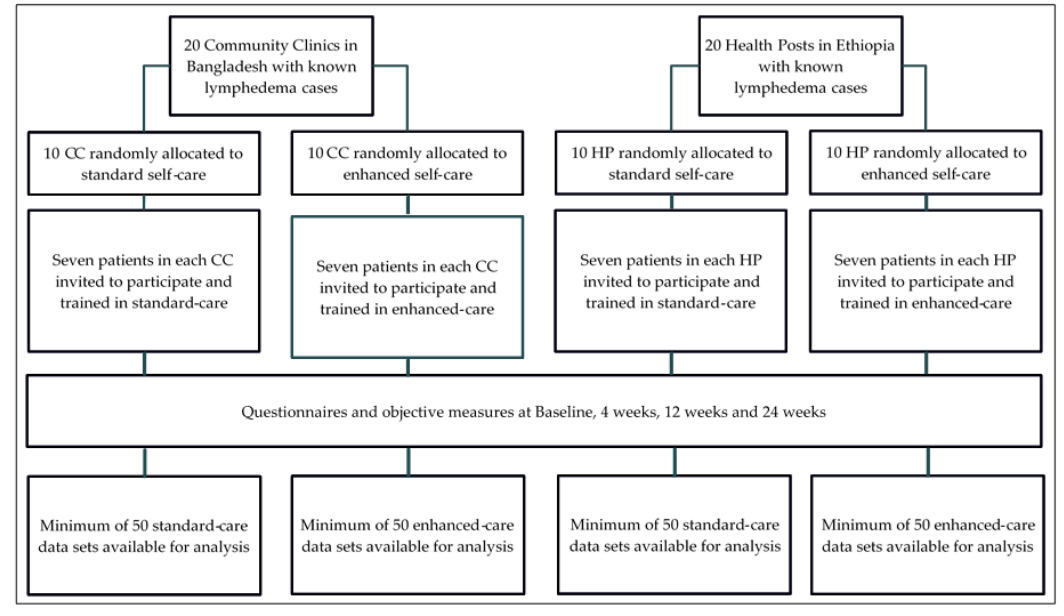
Figure 1. Flow chart showing the study design. CC = community clinic, HP = health post.